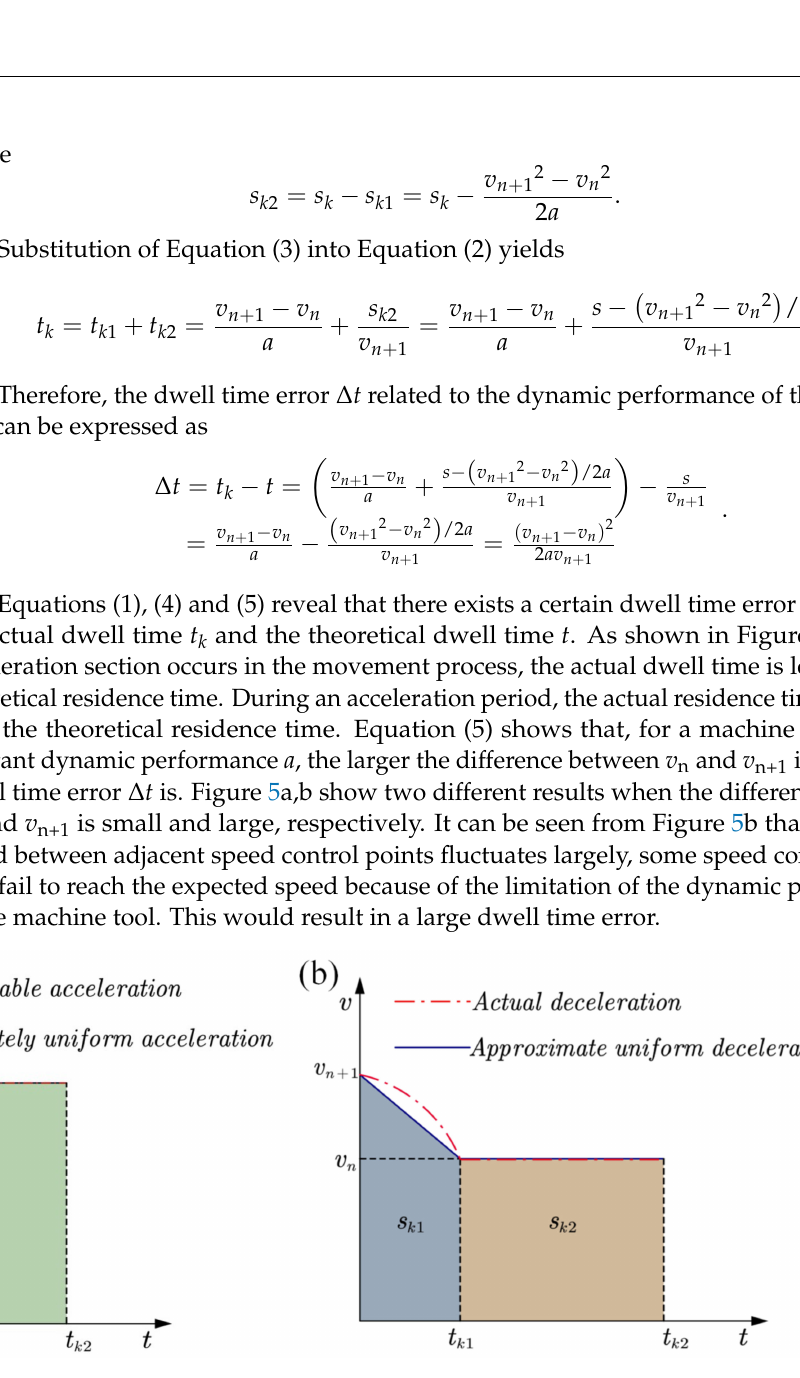
Figure 4. Dwell time error during: ( a ) acceleration process; ( b ) deceleration